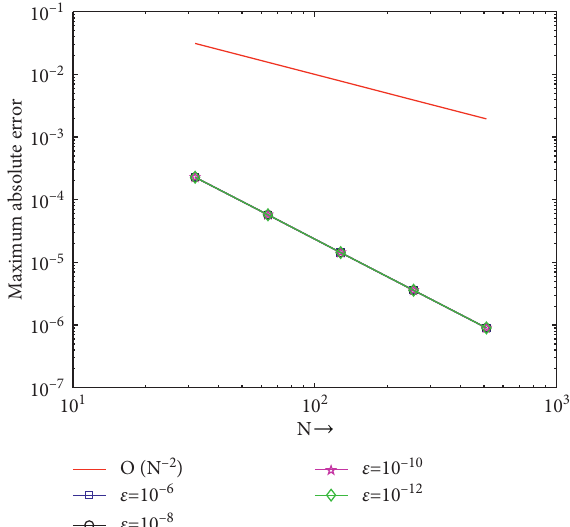
Figure 4: Log-log plot for Example 1 when μ � 10 − 6 .